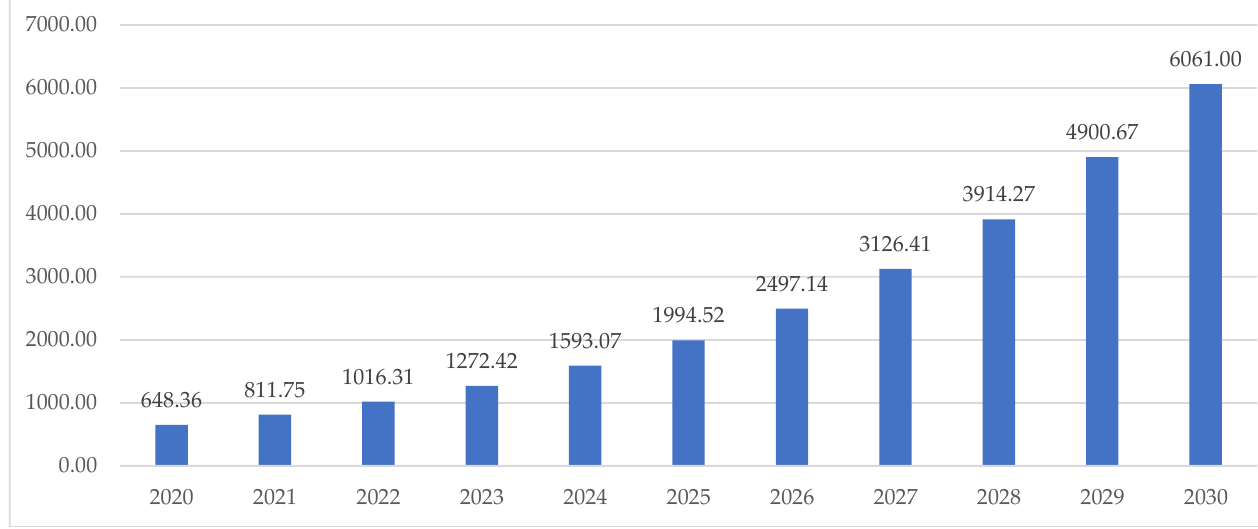
Figure 1. The value of the global market of smart city solutions and technologies in 2020–2030 on the basis of Allied Market Research data. Source: [81].